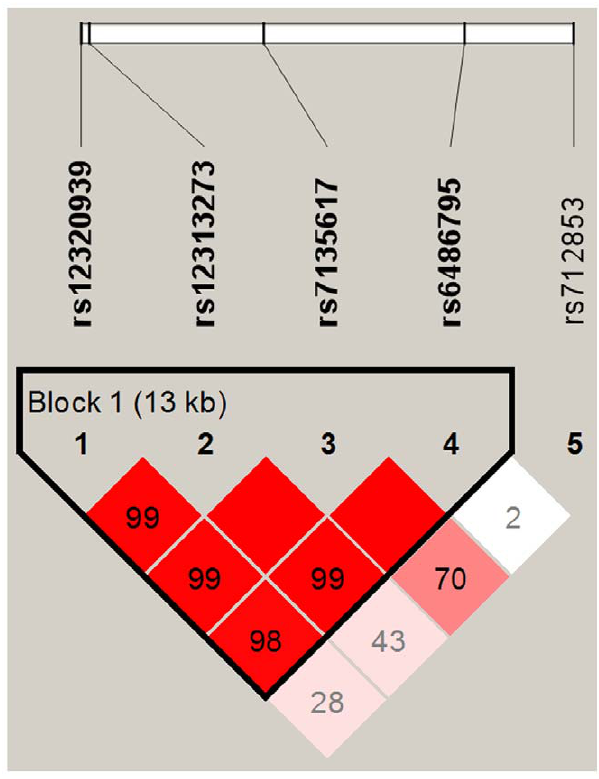
Figure 2. ORAI1 gene LD and haplotype block structure in AS. The number on the cell is the LOD score of D’.